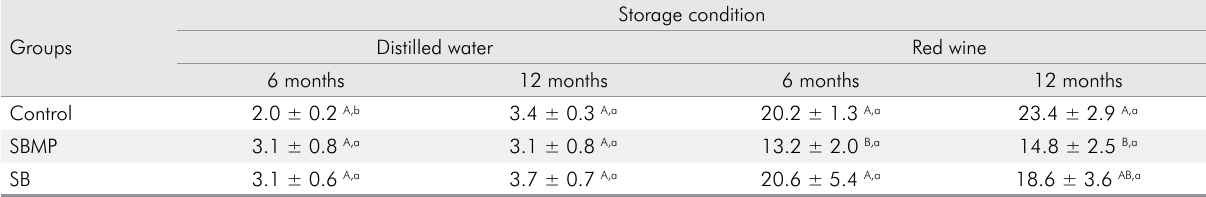
Table 2. Color change means and standard deviations (±SD) of groups after 6 and 12 months of water or wine storage.